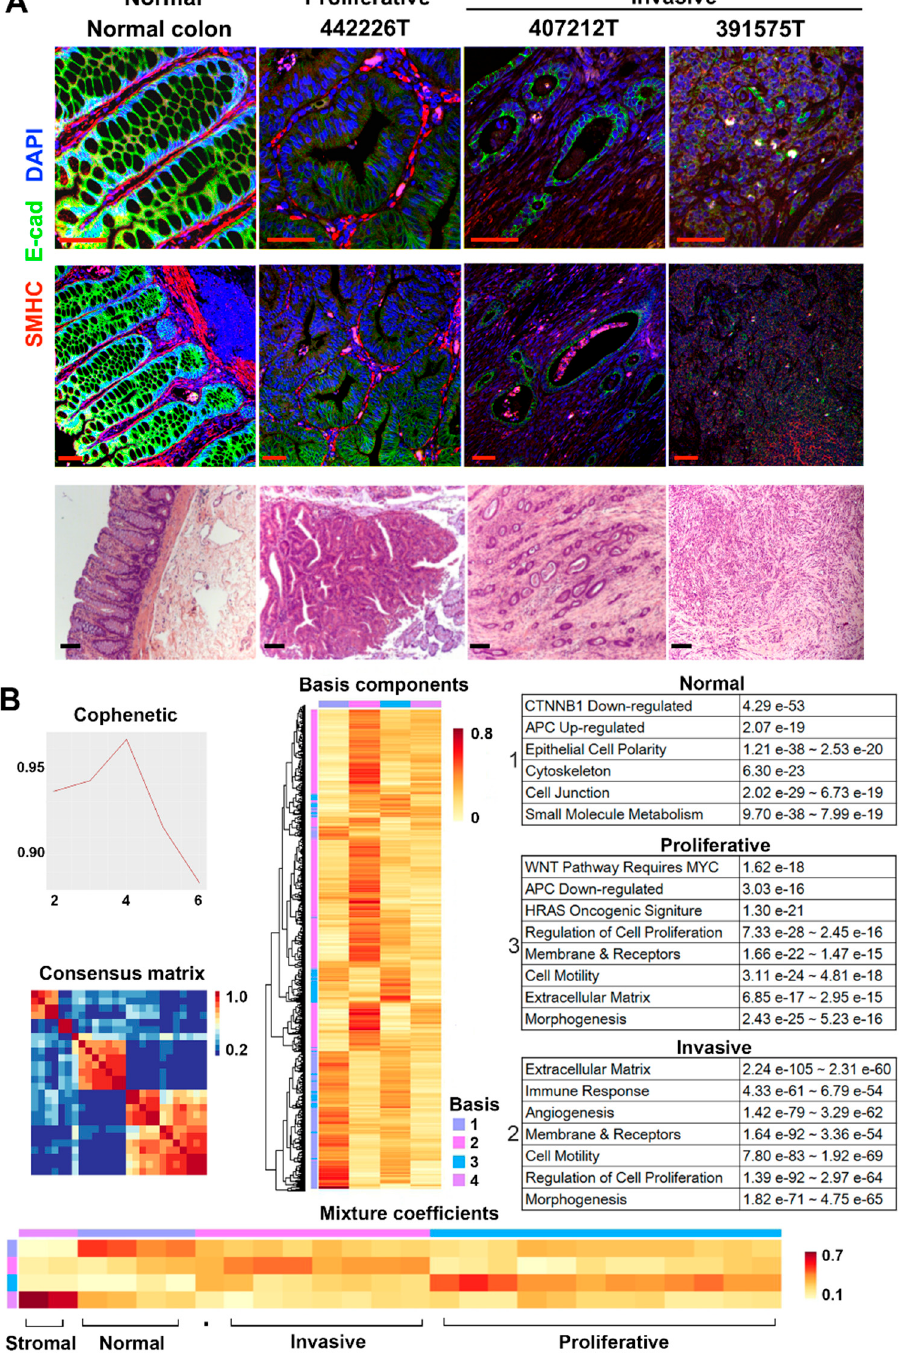
Figure 1. RNA-seq analysis clusters the tumors into two major groups-proliferative or invasive. ( A ) Representative confocal (top two panels) and H&E staining (bottom panel) images of canine colon normal tissues, proliferative and invasive tumors. E-cad: E-cadherin; SMHC: smooth muscle myosin heavy chain (SMHC). Scale bar: 100 µ M. ( B ) Non-negative matrix factorization (NMF) clustering identifies four metagenes (top left and middle columns), three of which have significantly enriched functions (top right column). The metagenes cluster the samples into four groups (bottom), with invasive and proliferative ones being the largest. See also Table S1 and Figure S1.